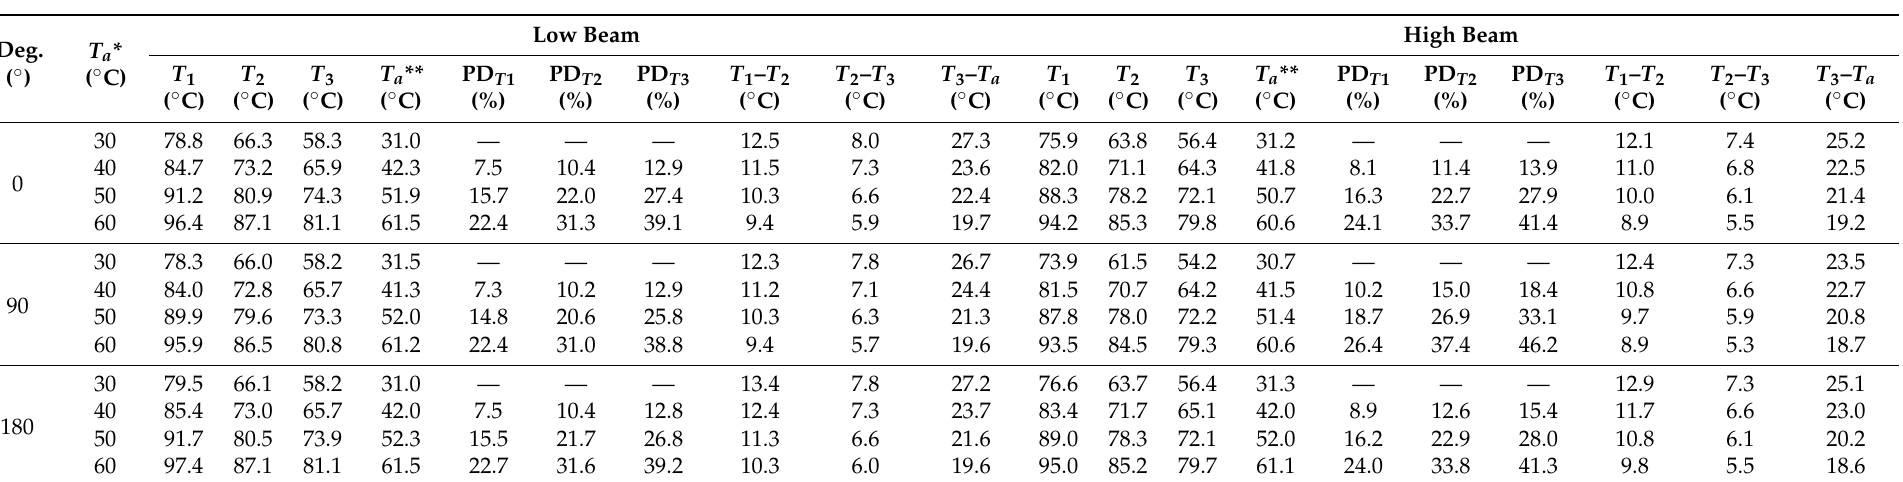
Table 4. Temperature measurement results of the LED